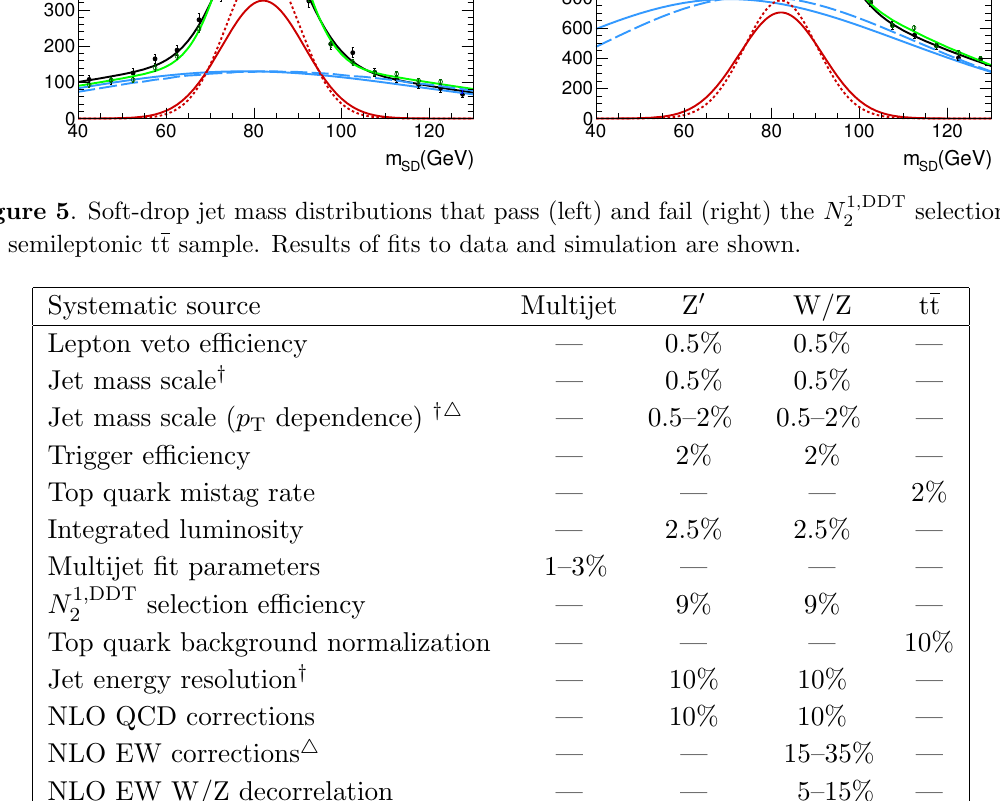
Table 1 . Summary of the systematic uncertainties for signal and background processes and their relative size. The symbol 4 denotes uncertainties decorrelated per p T bin in the 500{1000 GeV range. The symbol y denotes a shape uncertainty in the peaking SM W and Z boson backgrounds and Z 0 boson signal shape. A long dash (|) indicates that the uncertainty does not